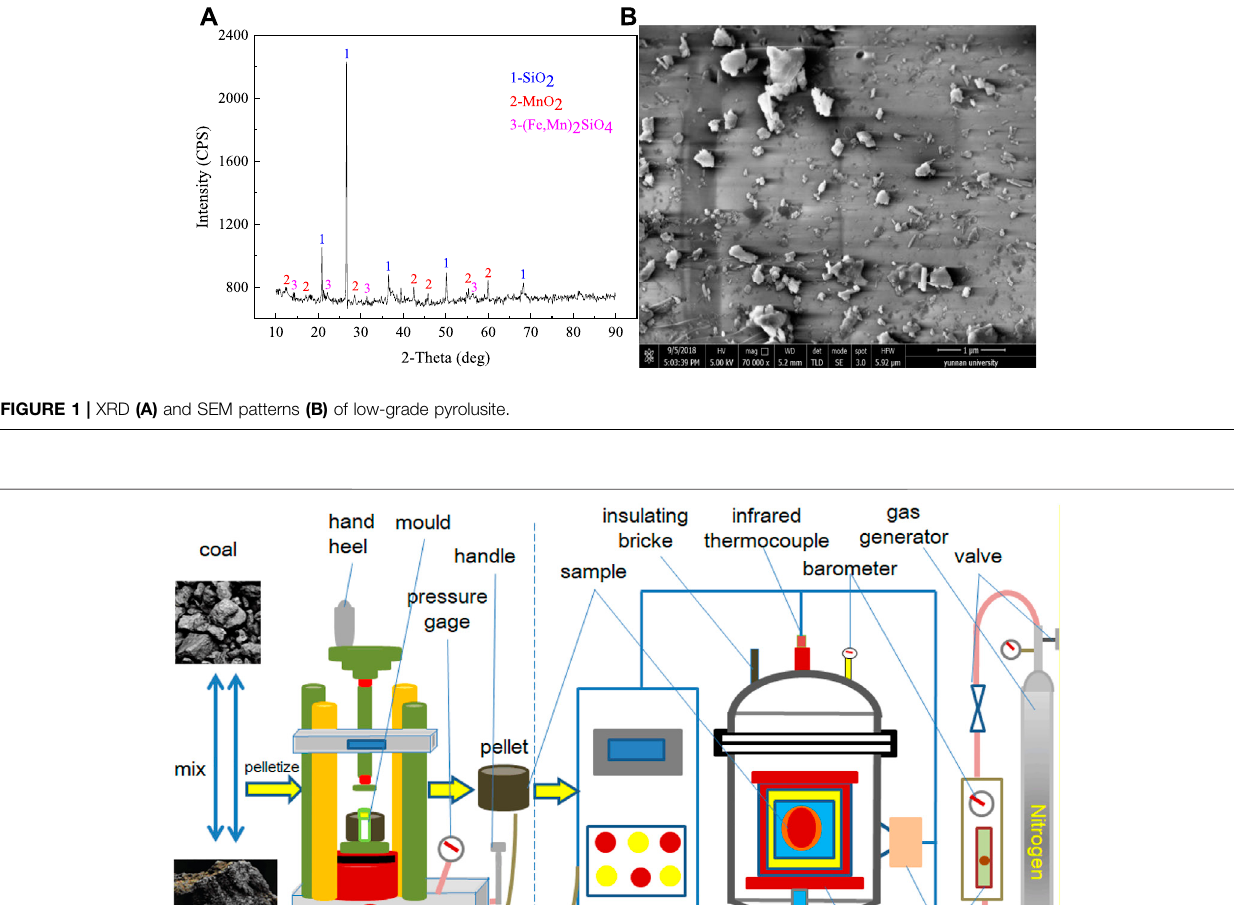
Frontiers in Energy Research |